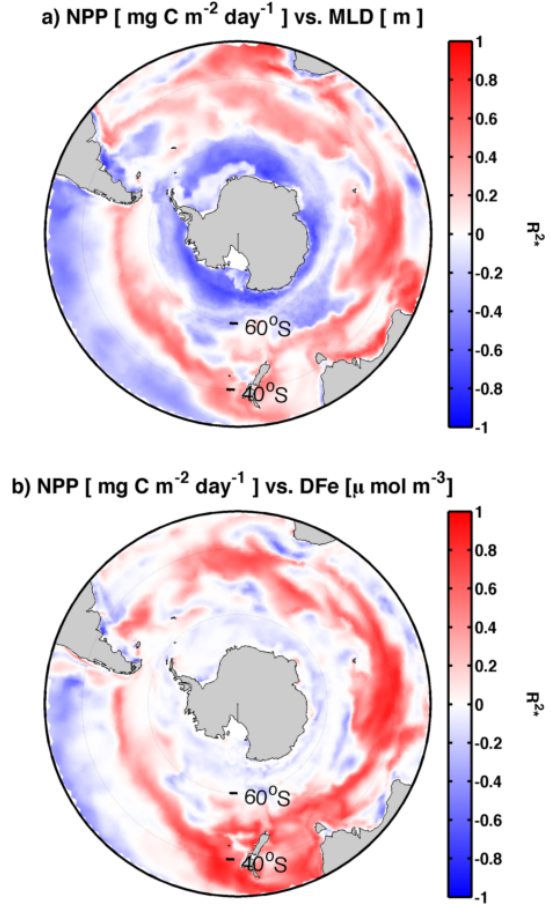
Figure 18. Maps showing coefficients of determination for cross- correlation between model results of (a) NPP and MLD and (b) NPP and DFe. DFe has been averaged over the upper 100m of the water for the calculation. R 2 ∗ is defined as the temporal coefficient of correlation multiplied by the sign of the regression